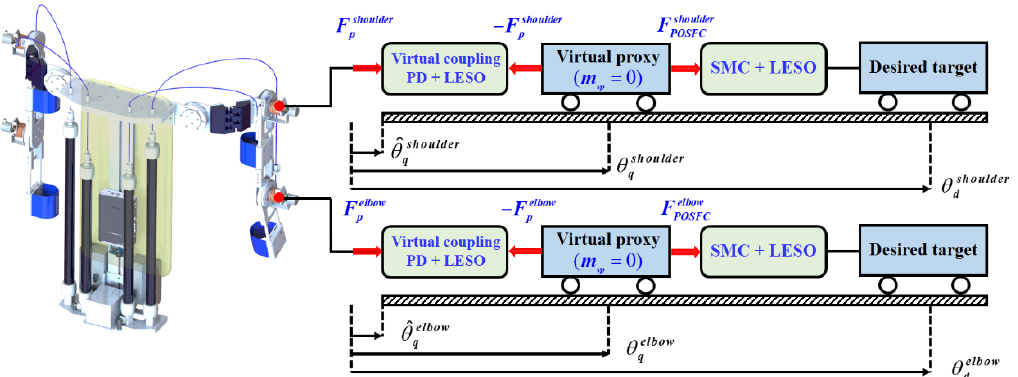
Figure 11. Principle of the proposed proxy-based output feedback sliding mode control (POFSC) for the shoulder and elbow joints.